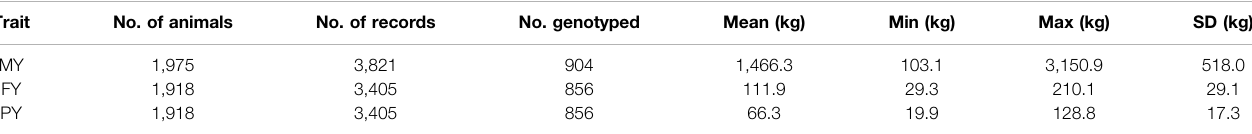
MY, milk yield; FY, fat yield; PY, protein yield.